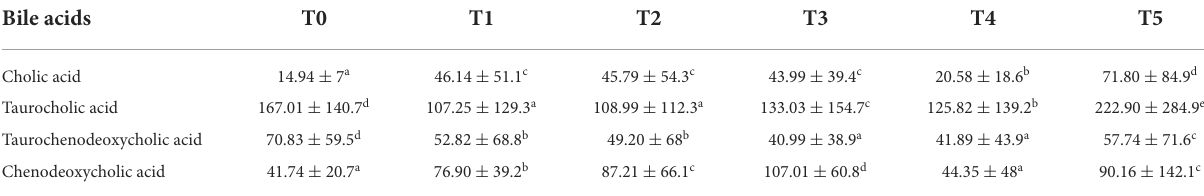
TABLE 8 Effects of adding CAP level (ng/mg) on bile acids in the digesta of white-feather broilers (means ± SEM). Bile